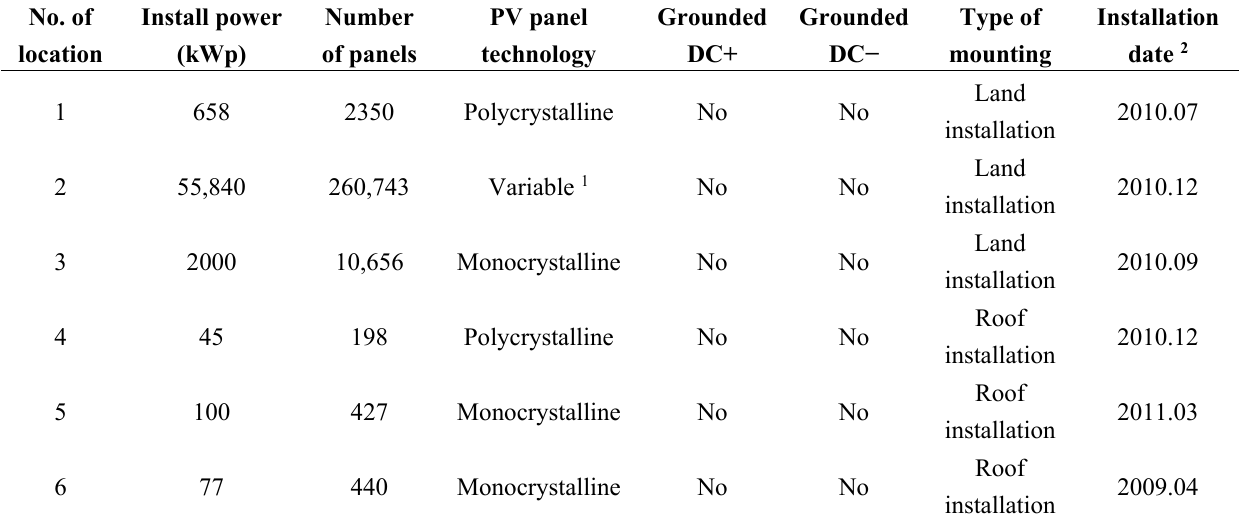
Table 4. Basic parameters and the technology used in the localities